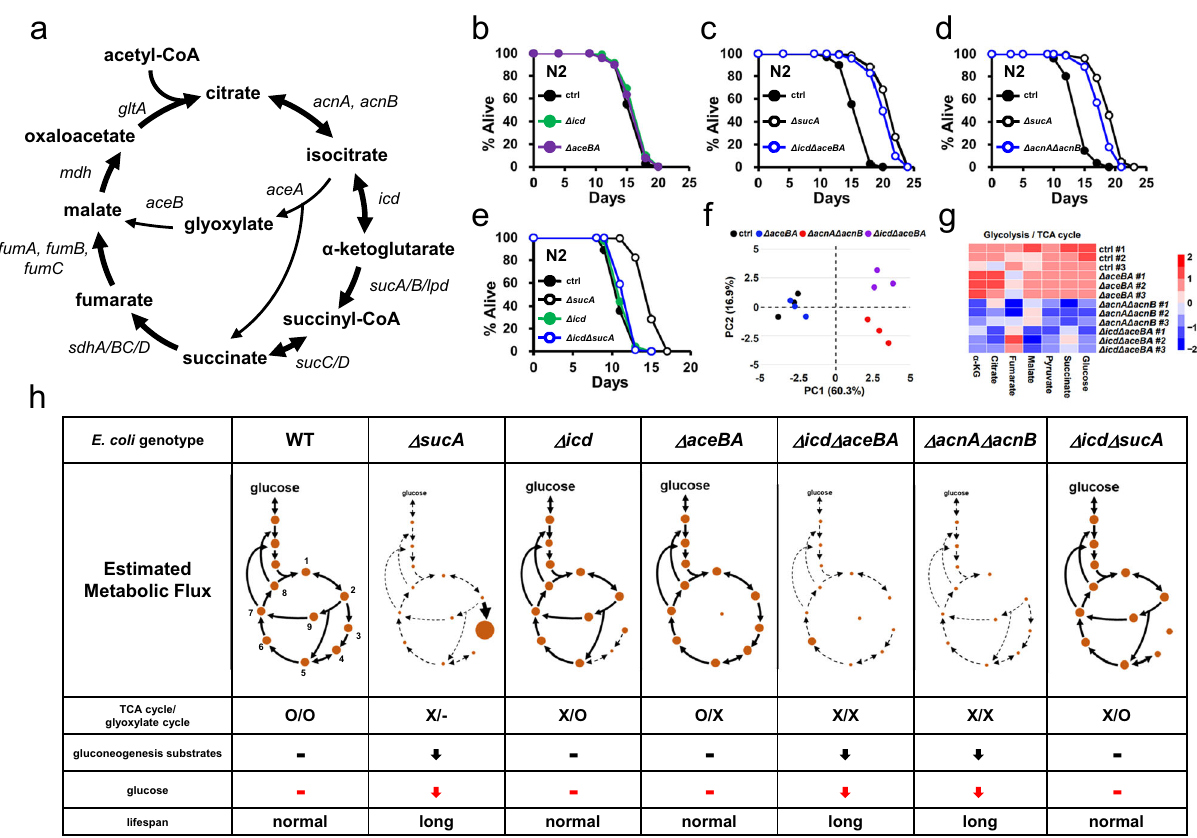
Fig. 2 | E. coli mutants simultaneously impaired in TCA and glyoxylate cycle prolong the longevity of C. elegans . a The TCA and glyoxylate cycles in E. coli . Metabolites are indicated in bold and genes encoding metabolic enzymes are indicated in italic. b – e Lifespan showing the effects of E. coli TCA and (or) glyox- ylate cycle mutations on C. elegans longevity. Neither Δ icd nor Δ aceBA E. coli mutants affect lifespan ( b ) while Δ icd Δ aceBA E. coli triple mutants extend lifespan ( c ). Δ acnA Δ acnB E. coli double mutants extended lifespan ( d ). Δ icd mutation abolished lifespan extension by Δ sucA E. coli mutants ( e ). Results from repre- sentative experiments are shown with additional repeats. f PCA analysis of meta- bolites from control, Δ aceBA , Δ icd Δ aceBA, and Δ acnA Δ acnB E. coli . Metabolites from three biological repeats are analyzed using 1 H-NMR. PC1 and PC2 indicate principal component 1 and principal component 2. Each point represents an independent biological sample. g Heat map analysis of metabolite quanti fi cation